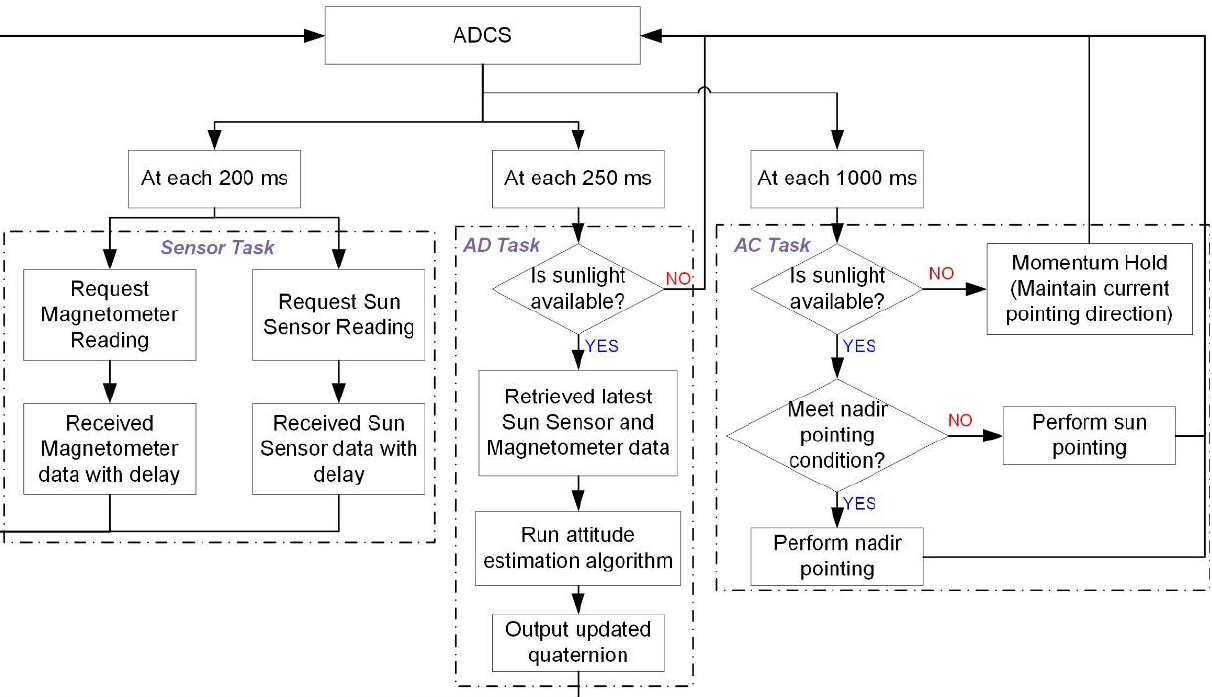
Figure 4. Process flow of sensor task, attitude determination (AD) task, and attitude control (AC) task for attitude determination Monte Carlo simulation.